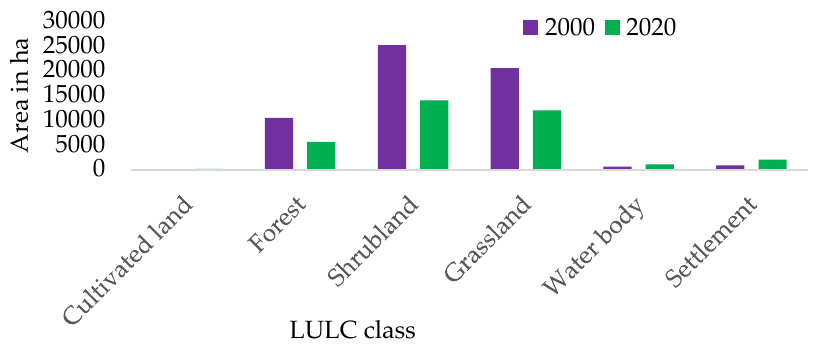
Figure 8. Changes in LULC from 1986 to 2021 in Rib watershed, Ethiopia. (Source of data: Anley et al., 2022 [72], but figure done by authors).